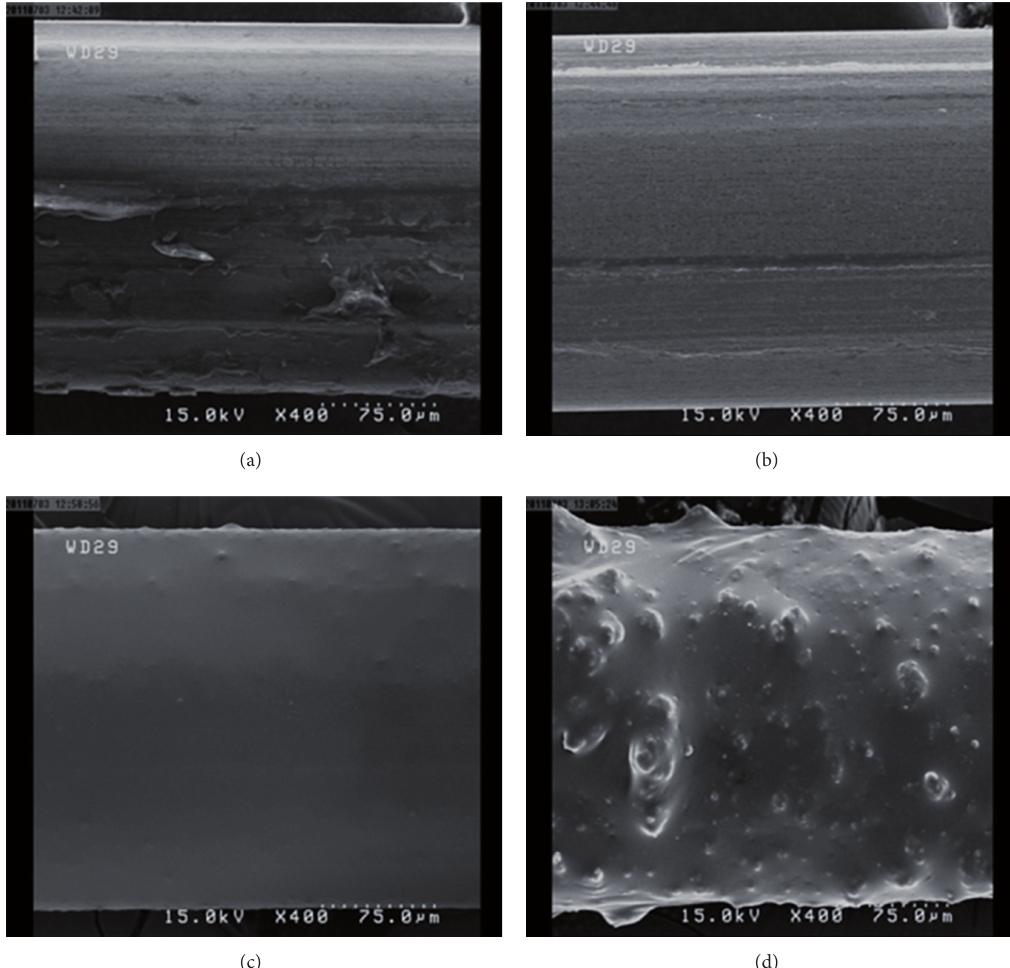
F 3: Scanning electron microscopy of (a) Cu wire, (b) Cu wire modi�ed by self-assembled monolayer of 3MPTS, (c) PDMS coating on modi�ed Cu wire, and (d) silica NPs-incorporated PDMS on modi�ed Cu